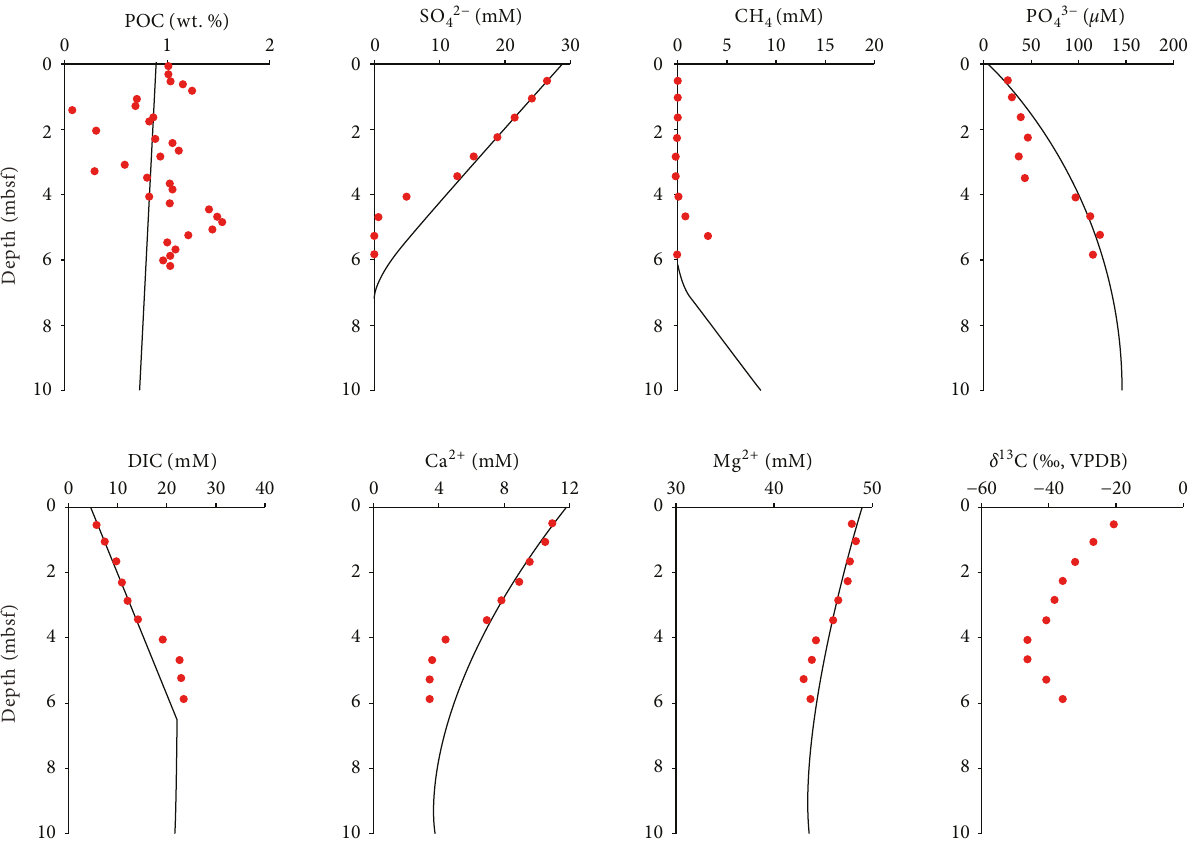
Figure 2: Measured (dots) and simulated (curves) depth pro fi les of core CL30. Down-depth concentration of particulate organic carbon (POC), sulfate (SO 42- ), methane (CH ), phosphate (PO 43- ), dissolved inorganic carbon (DIC), calcium (Ca 2+ ), magnesium (Mg 2+ ), and 4 δ 13 C is DIC